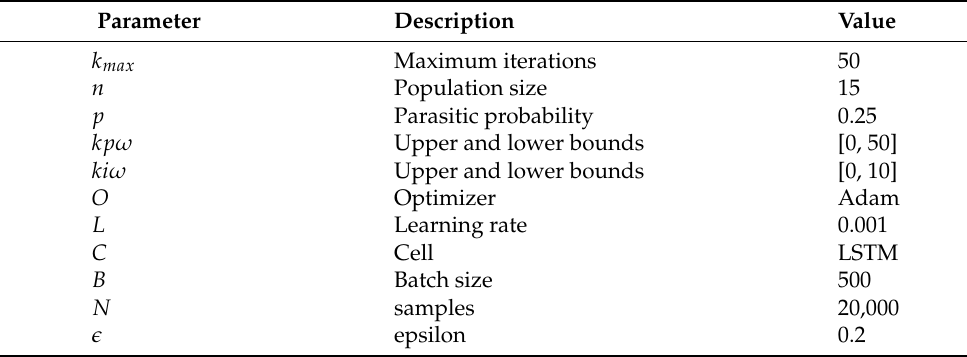
Table 2. Cuckoo optimization and RNN hyper-parameter